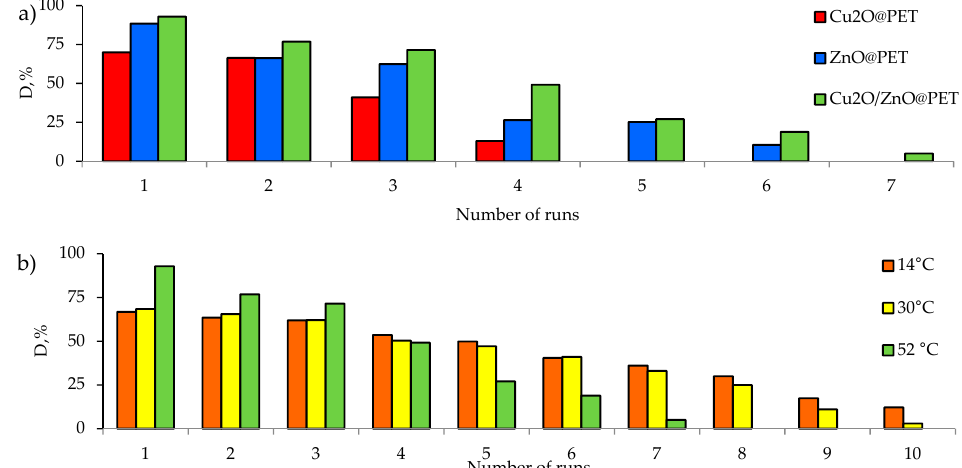
Figure 12. Variation in the degradation of Czm (1.0 mg/L) with different composite TeM catalysts for several consecutive runs at 52 ◦ C ( a ), along with the reusability of Cu 2 O/ZnO@PET at different temperatures ( b